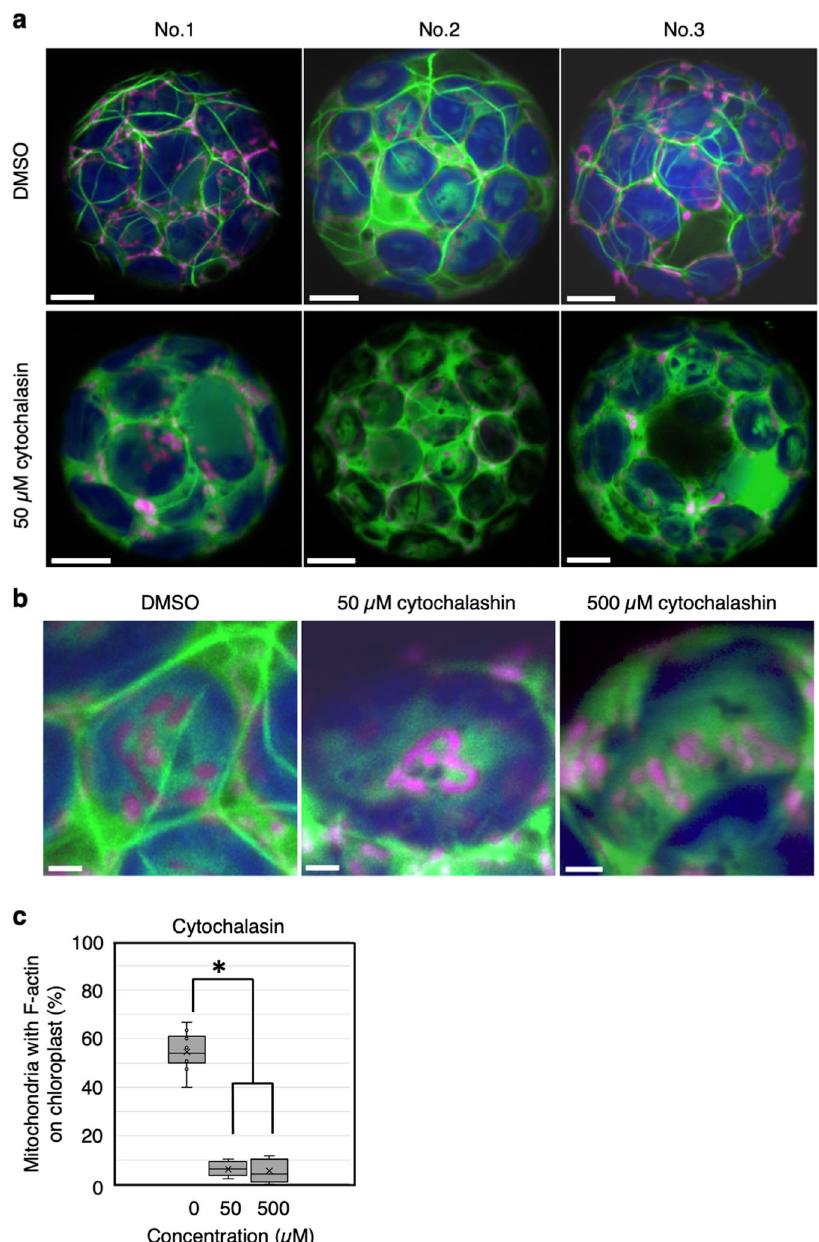
Fig. 5 F-actin-independent association between mitochondria and chloroplasts. a Representative images of F-actin (green) and mitochondria (magenta) in three different protoplasts treated without (DMSO) or with 50 µ M cytochalasin B (cytochalasin). Scale bars: 5 µ m. b Enlarged images of mitochondria and F-actin on the chloroplast surface in protoplasts treated with 0 µ M, 50 µ M, and 500 µ M cytochalasin. Scale bars: 5 µ m. c Quanti fi cation of the number of mitochondria associated with F-actin on chloroplasts. The number of mitochondria in protoplasts without (DMSO) vs. with 50 µ M or 500 µ M cytochalasin differed (Student ’ s t test,